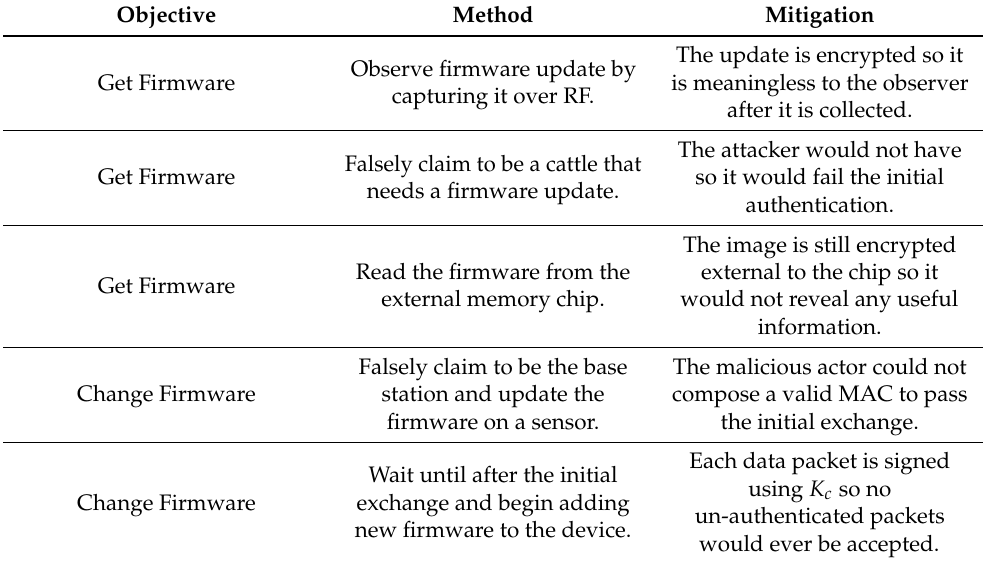
Table 5. The summary of the security risks and